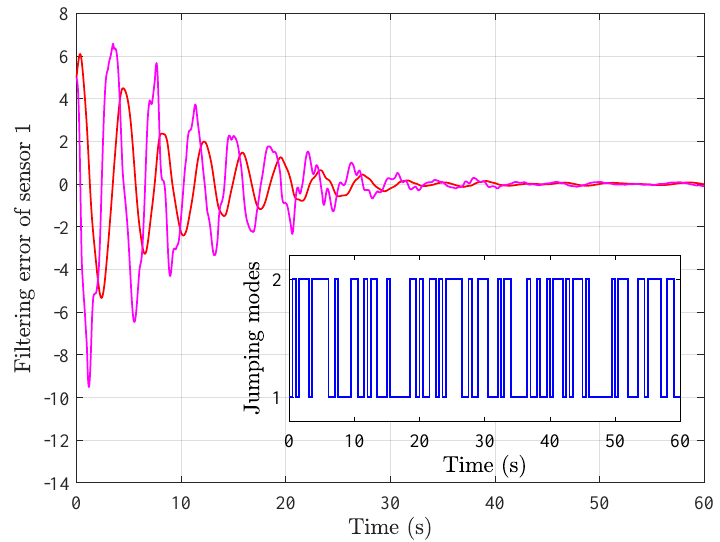
Figure 3. Filtering errors of sensor 1.